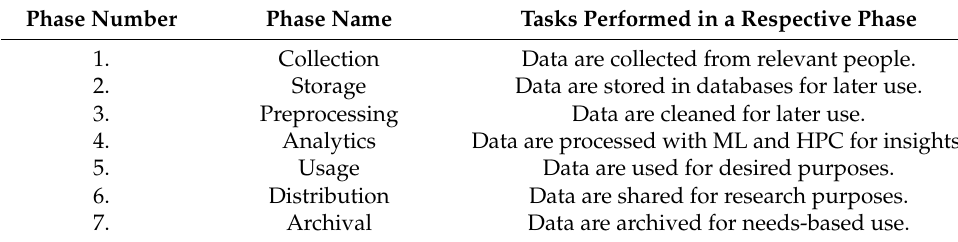
Table 1. Concise overview of the data life cycle employed to combat the